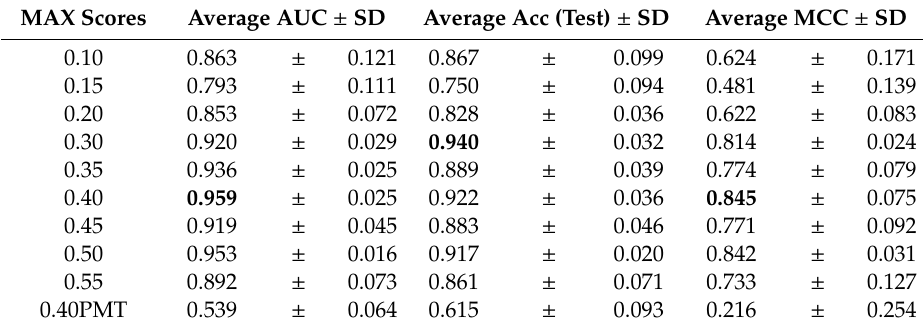
Table 1. Performance of prediction models with thresholds of MAX score by DeepSnap-DL.